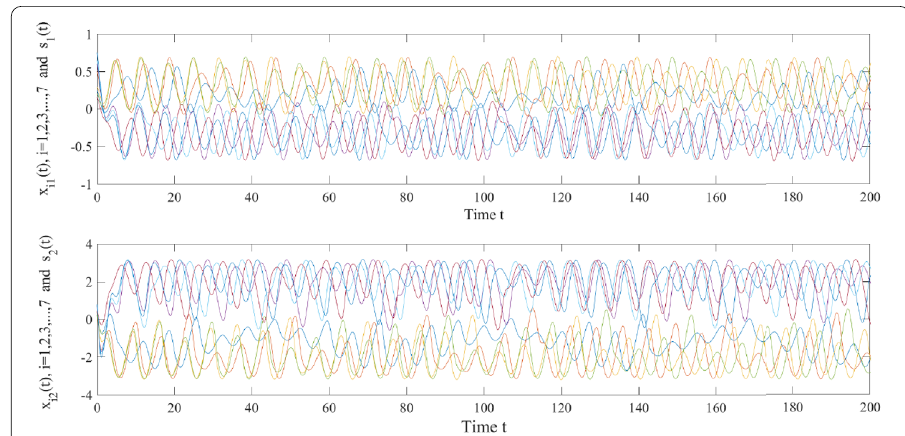
Figure 5 The state trajectory of the isolated node α ( t ) s ( t ) (42) and network x i ( t ) (1)